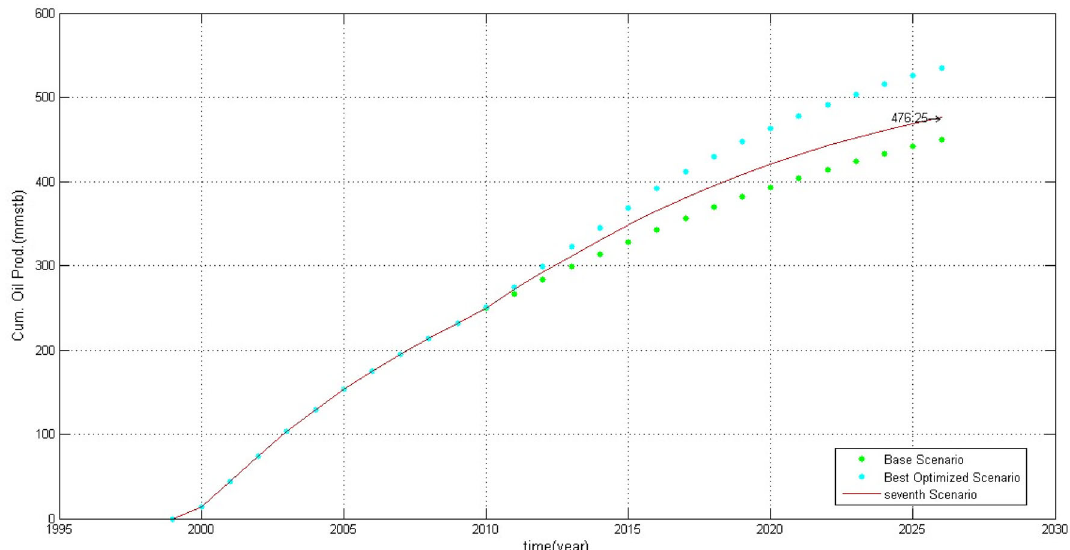
Fig. 14 Cumulative oil production of seventh